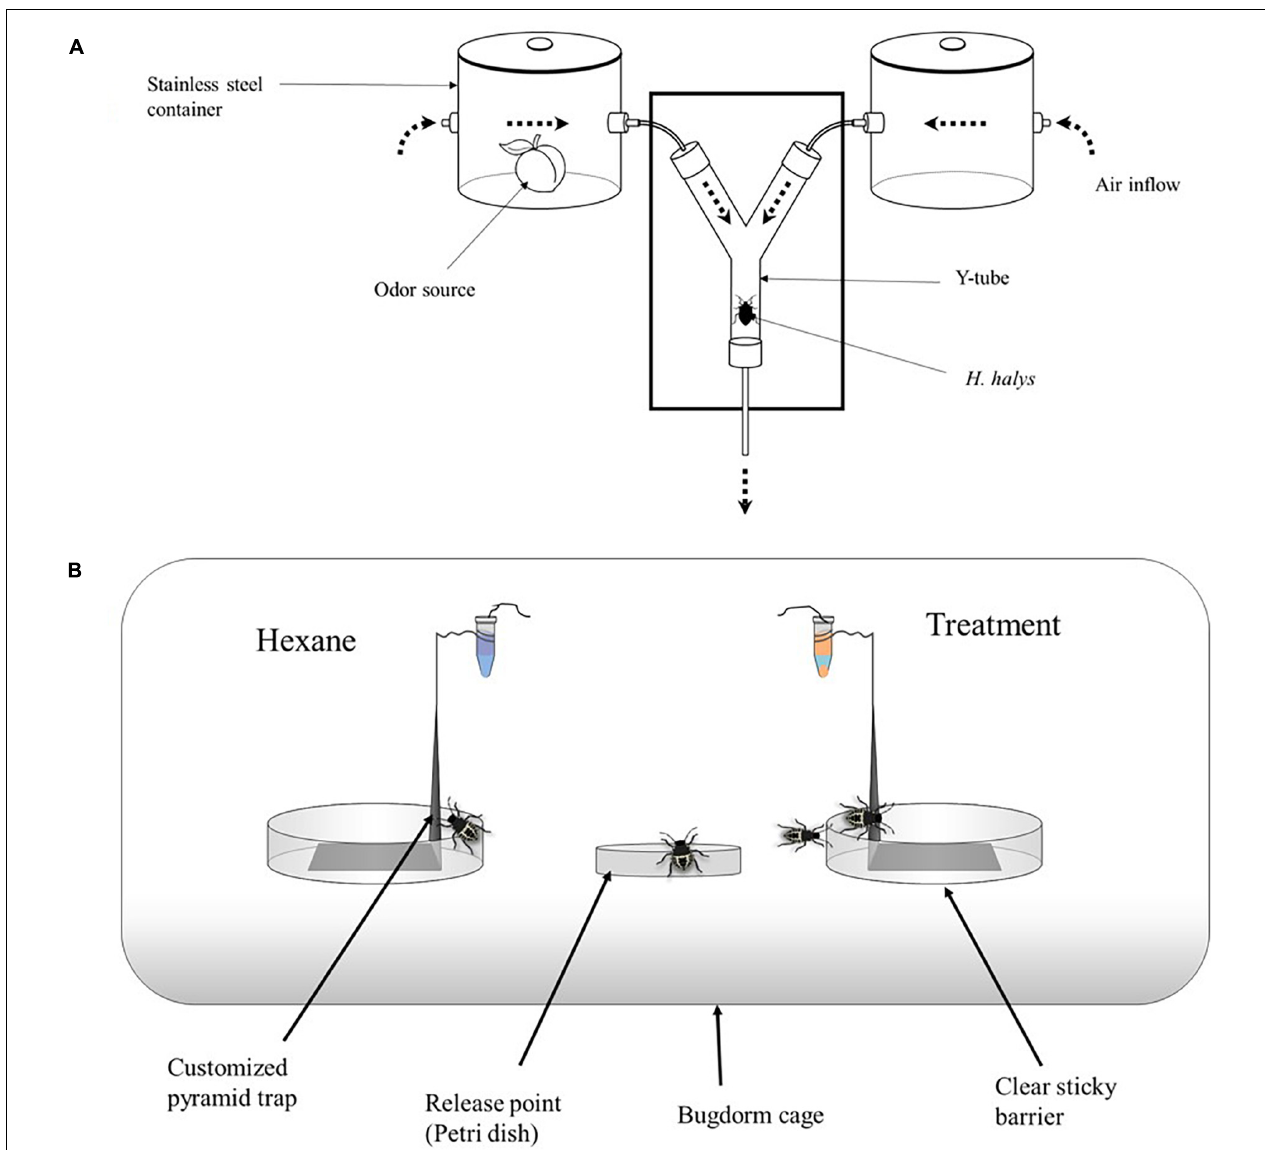
FIGURE 1 | (A) Customized olfactometer, showing the source of stimuli via airflow through each of the two arms. Air was pumped from a gas cylinder through the stainless container to the two-way part of the olfactometer. The flow rate of the air was checked regularly, ensuring that it was 100 ml/min through each arm (200 ml/min into the central portion of the olfactometer). (B) Greenhouse setup consisted of a customized black pyramid trap placed in a bugdorm and nymphs released from the center of the two treatments. The pyramid trap is 15 cm tall and 10 cm wide at the base. These were placed in a 90 × 45 × 45 BugDorm tent. The release mechanism consisted of a 1.5-ml microcentrifuge vial with a cotton string ( ∼ 2.5 cm long) threaded through a hole drilled (0.125 mm) through the lid and placed on top of the pyramid trap.